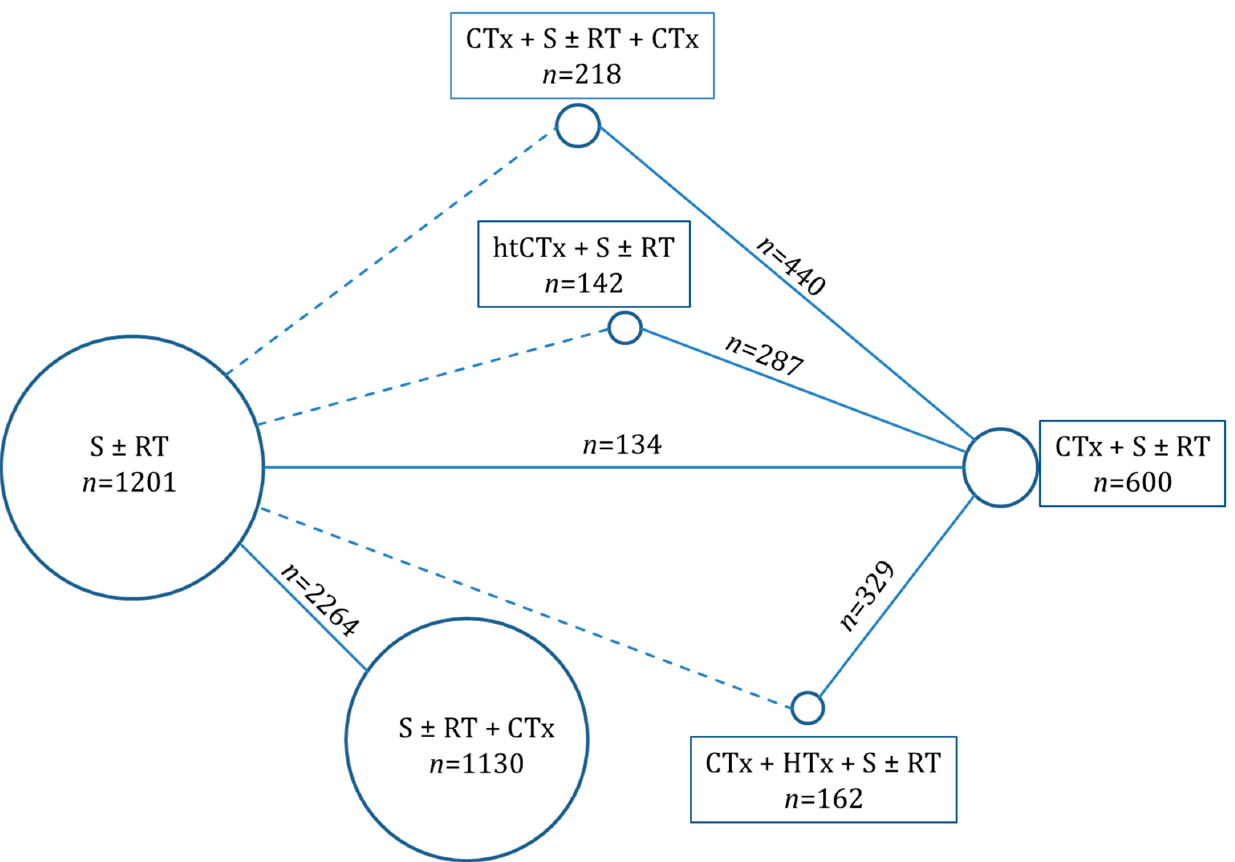
Figure 2. Overview of the network meta-analysis. Shown are the different treatment modalities with the direct comparisons (solid lines) and indirect comparisons (dashed lines) and the respective number of patients in the direct comparisons. Abbreviations: S = surgery, RT = radiotherapy, CTx = chemotherapy, HTx = hyperthermia, and htCTx = histology tailored chemotherapy. Table 1. Overview of included trials. * = baseline characteristics from SMAC meta-analysis.